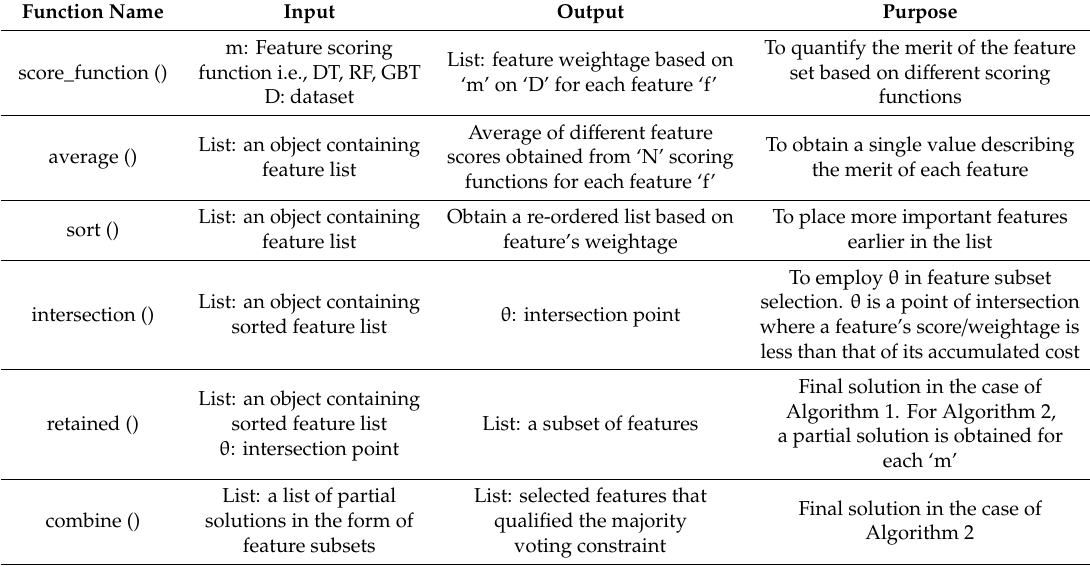
Table 2. Summary table for elaborating the proposed